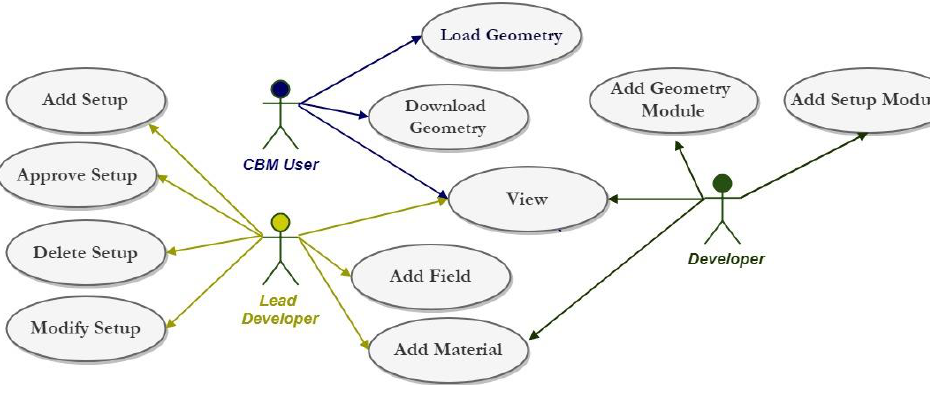
Fig. 1. The structure of the CBM setup .